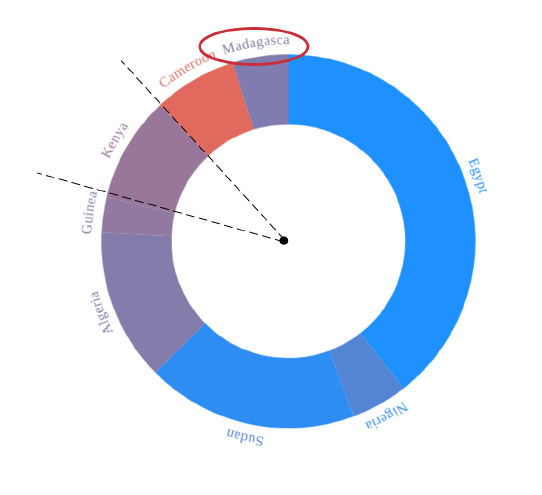
Figure 4. Path arrangement